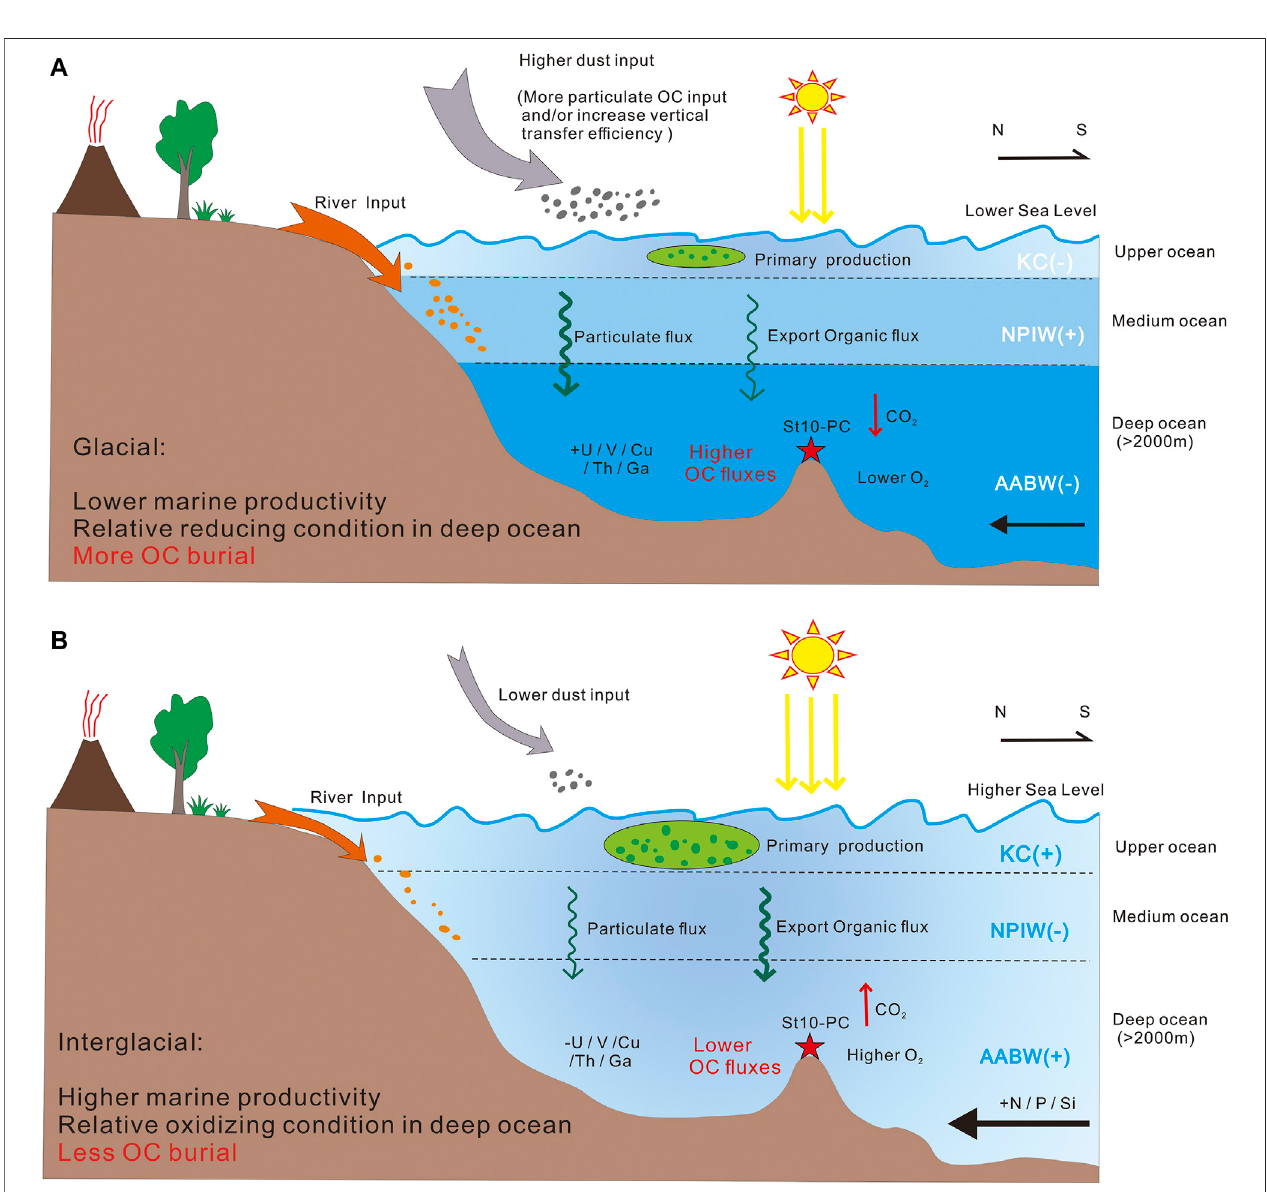
FIGURE6| Schematic modelsofOCburial regimesassociatedwithterrestrialOCinputbyriverand eolian dust,marine productivity, and redoxconditionsderived from marine circulation and RSEs in the mid-latitude Northwest Paci fi c Ocean during (A) glacial and (B) interglacial periods.